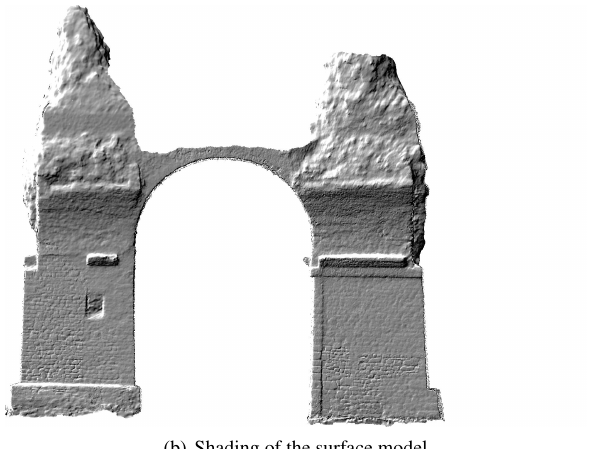
Figure 6: Selected facade acquired by dense surface matching of the MLS image data. Upper image: Visualisation of the point density model; Lower image: shading of the resulting 2.5D sur- face model.